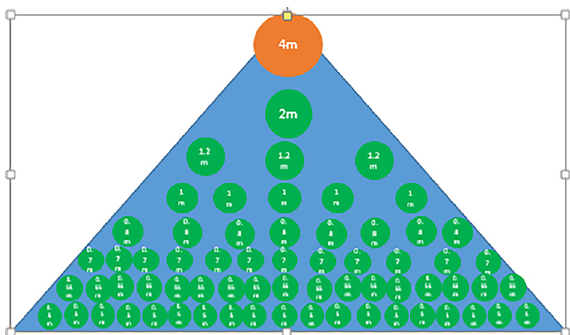
Fig. 13. Diagram of the theoretical hierarchical distribution of cities and urban areas with their ranks in the Makkah Province. Source: Ledraa